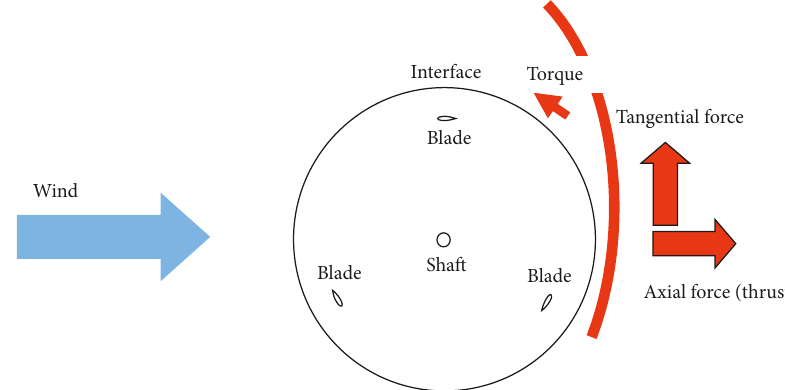
Figure 4: Distribution of various forces and torque impacting the Darrieus rotor.